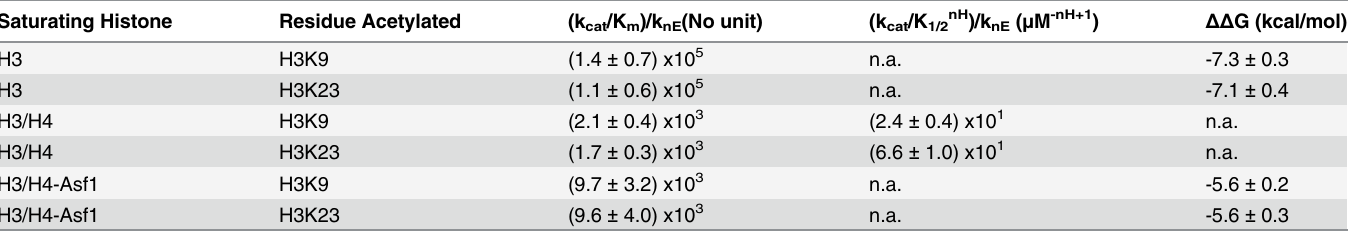
Table 4. Catalytic pro fi ciency of Rtt109-Vps75-mediated acetylation from acetyl-CoA titration (mean ± standard error). Saturating